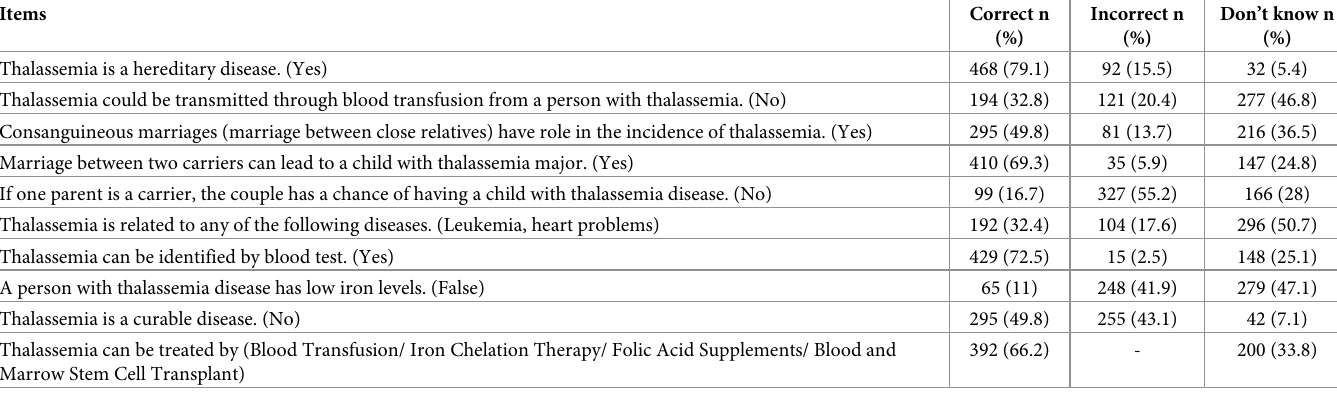
Table 3. Knowledge about thalassemia among the participants who have heard regarding thalassemia (n =